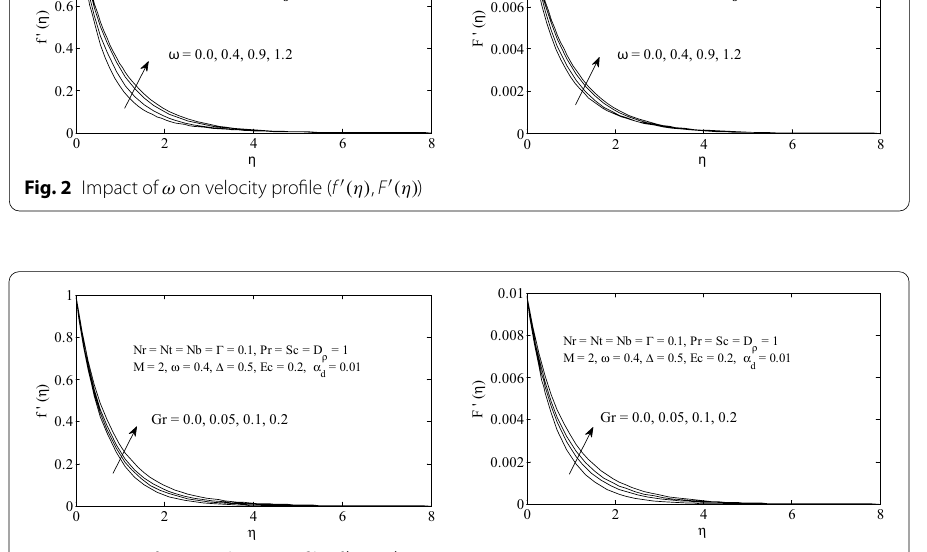
Fig. 3 Impact of Gr on velocity profile ( f ′ (η) , F ′ (η)